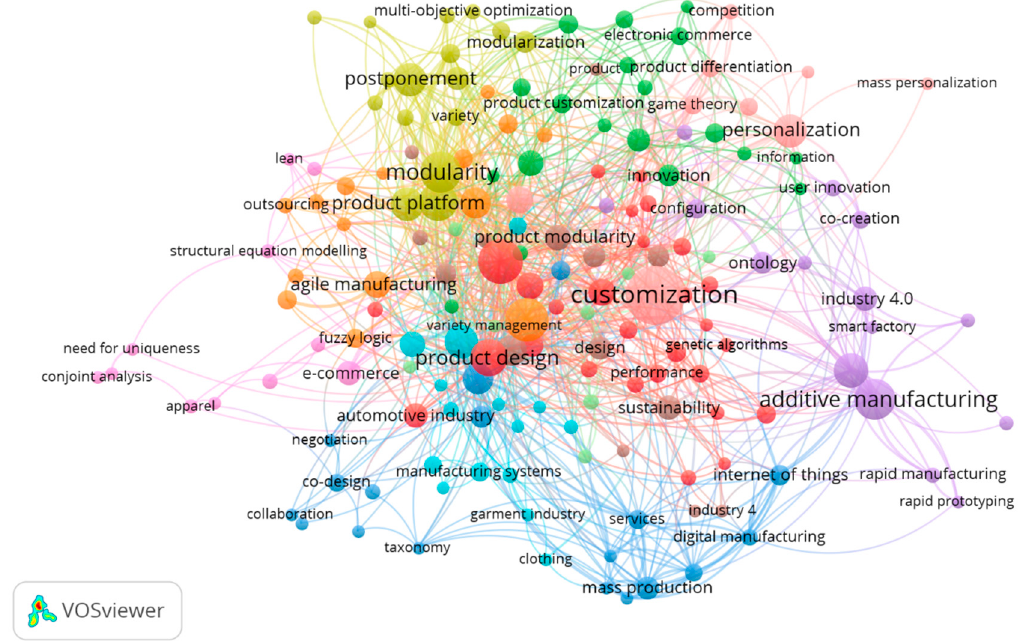
Figure 7. Co-occurrence of author’s keywords in the Mass Customization domain (1990–2020). Source: Composed by the authors using VosViewer software .